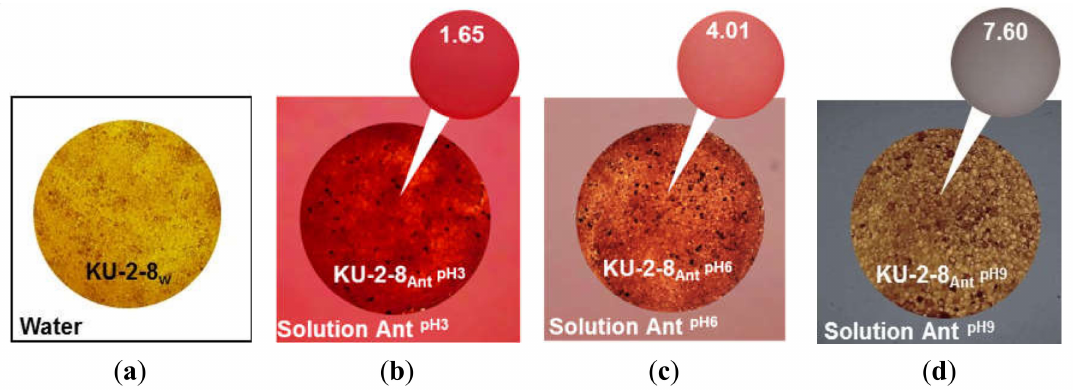
Figure 8. Color of the cation-exchange resin KU-2-8 in the Na + form, equilibrated with deionized water ( a ) and anthocyanin solutions at pH 3 ( b ), 6 ( c ), and 9 ( d ). The upper circles represent the closest anthocyanin color on the colorimetric scale in solution (Figure 4); the number inside the circle indicates the pH value corresponding to that